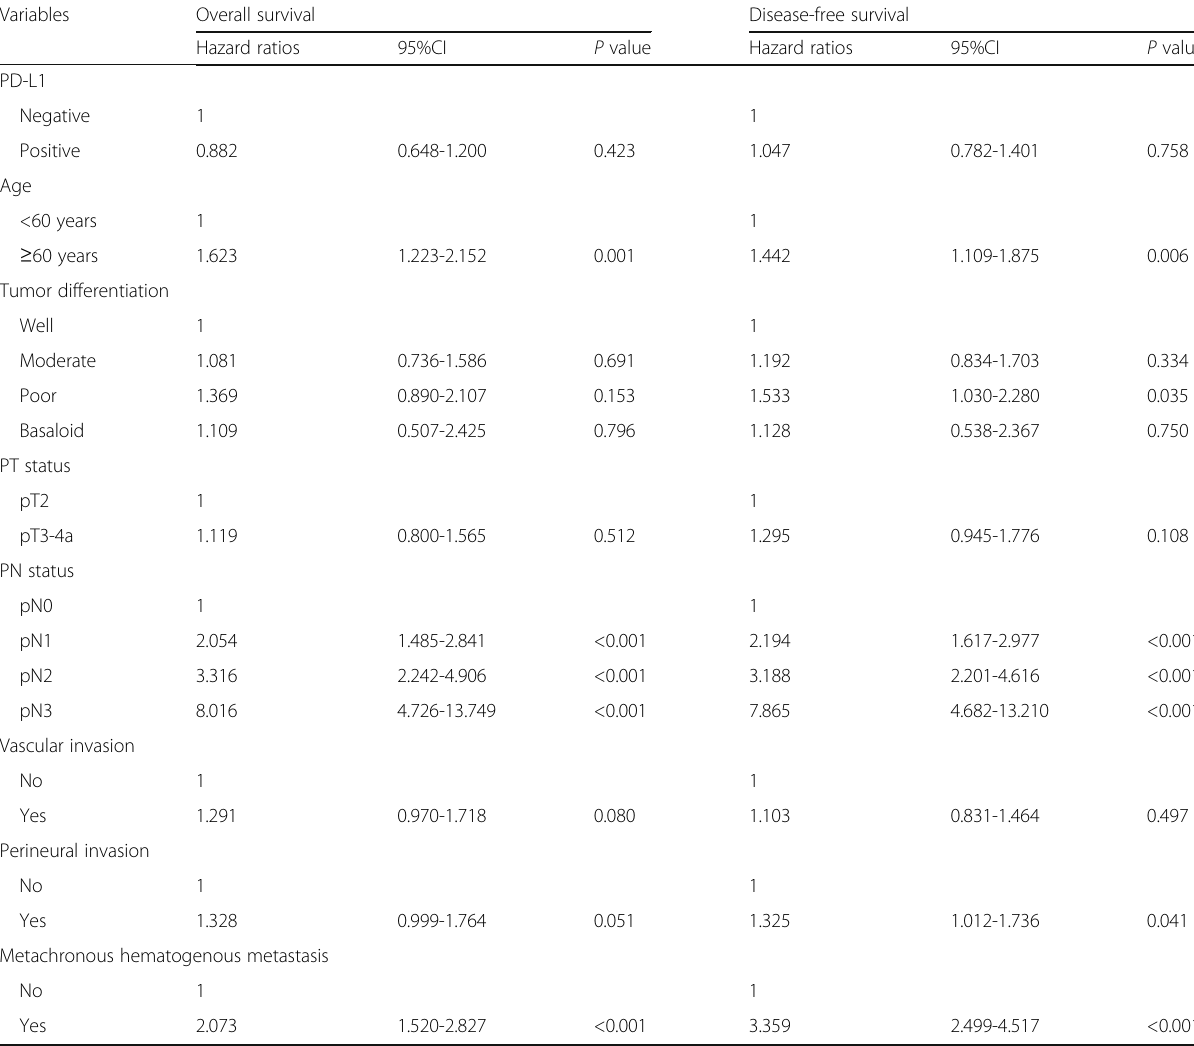
Table 6 Multivariate Cox analysis to determine independent factors associated with patient survival for PD-L1 expression in tumor cells